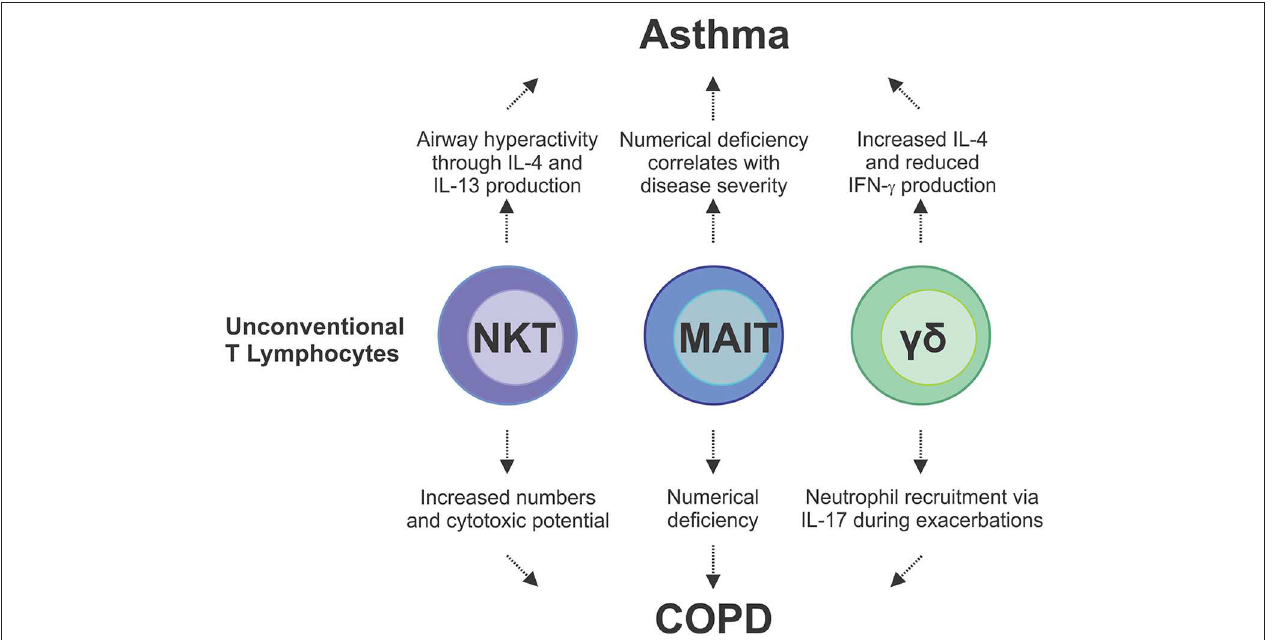
FIGURE 3 | Unconventional lymphocytes are implicated as pathogenic mediators of asthma and COPD and disease exacerbations. In asthma, IL-4 and IL-13 cytokines produced by NKT cells are directly involved in disease development which is compounded by additional IL-4 production from γδ -T cells. Conversely there is a reduction in IFN- γ producing γδ -T cells and MAIT cells, which correlates with disease severity in asthma and COPD. In COPD, there is an increase in NKT cell numbers and cytotoxicity in the lungs, and IL-17-mediated neutrophilia, which is driven by γδ -T cells, both of which contribute to lung damage. These studies demonstrate the complex interplay and multifaceted contributions from the different types of unconventional T cells to chronic lung disease.